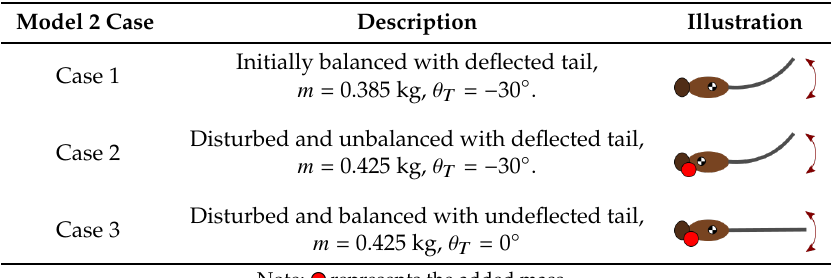
Table 7. Model 2 cases for correction of imbalance.